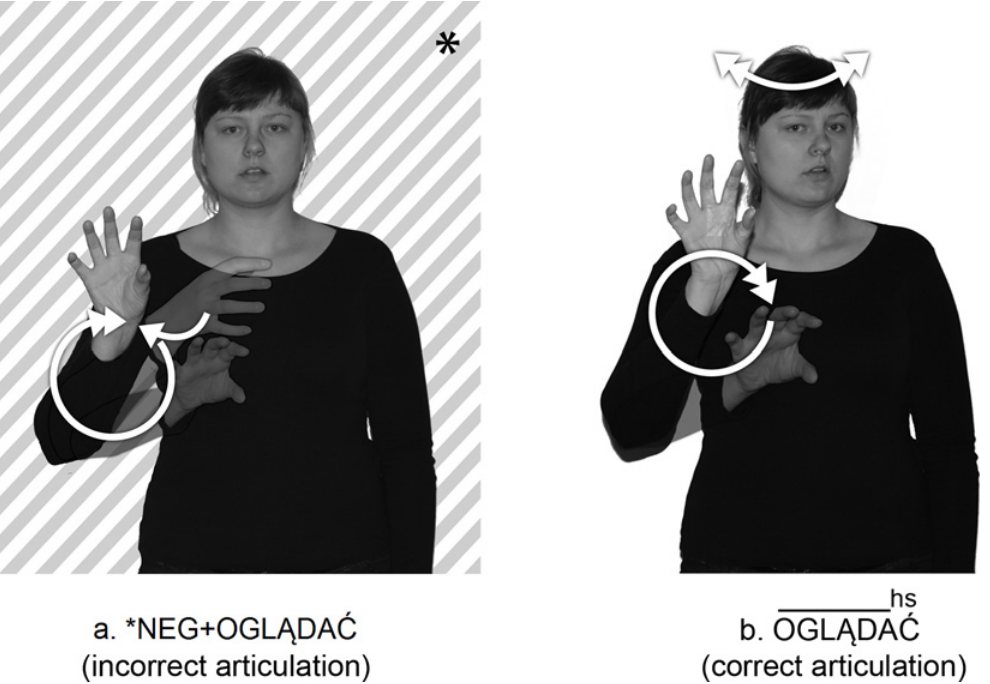
Fig 7. Examples of two signs. The individual in this figure has given written informed consent (as outlined in PLOS consent form) to publish these case